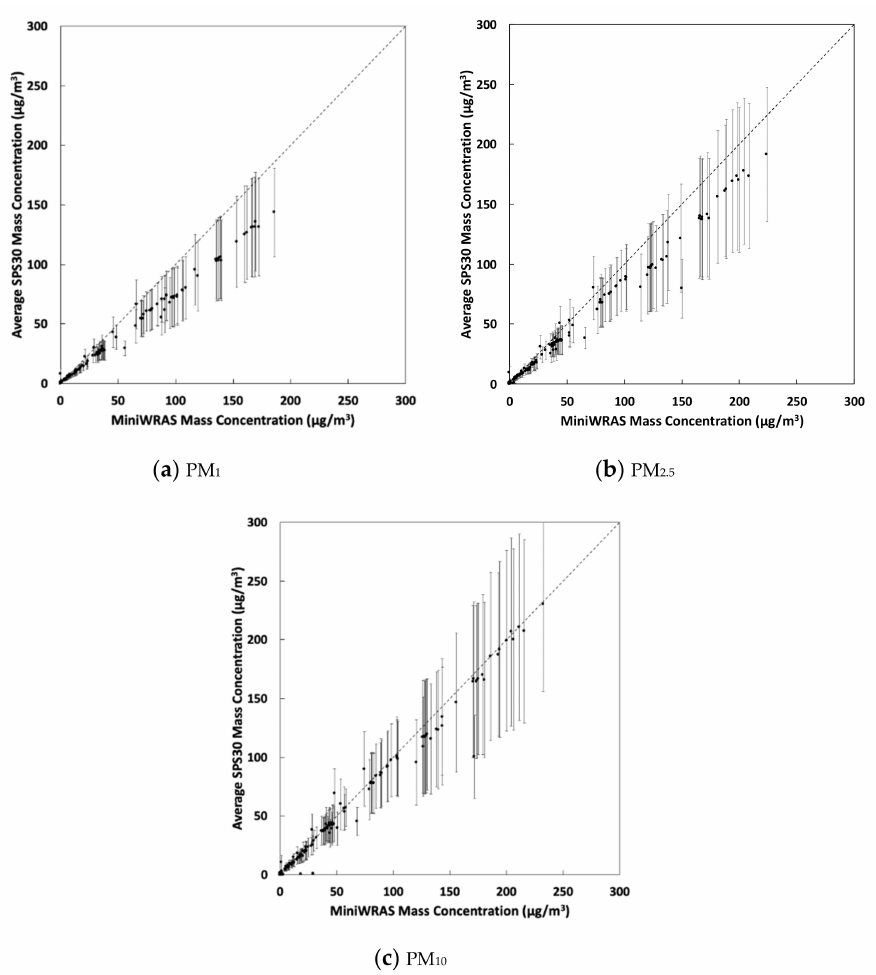
Figure 4. Scatter plots between the average GeoAir and the MiniWRAS data for ( a ) PM 1 ; ( b ) PM 2.5 ; and ( c ) PM 10 for varying levels of salt concentration. The y axis error bars represent the standard deviation of the GeoAir